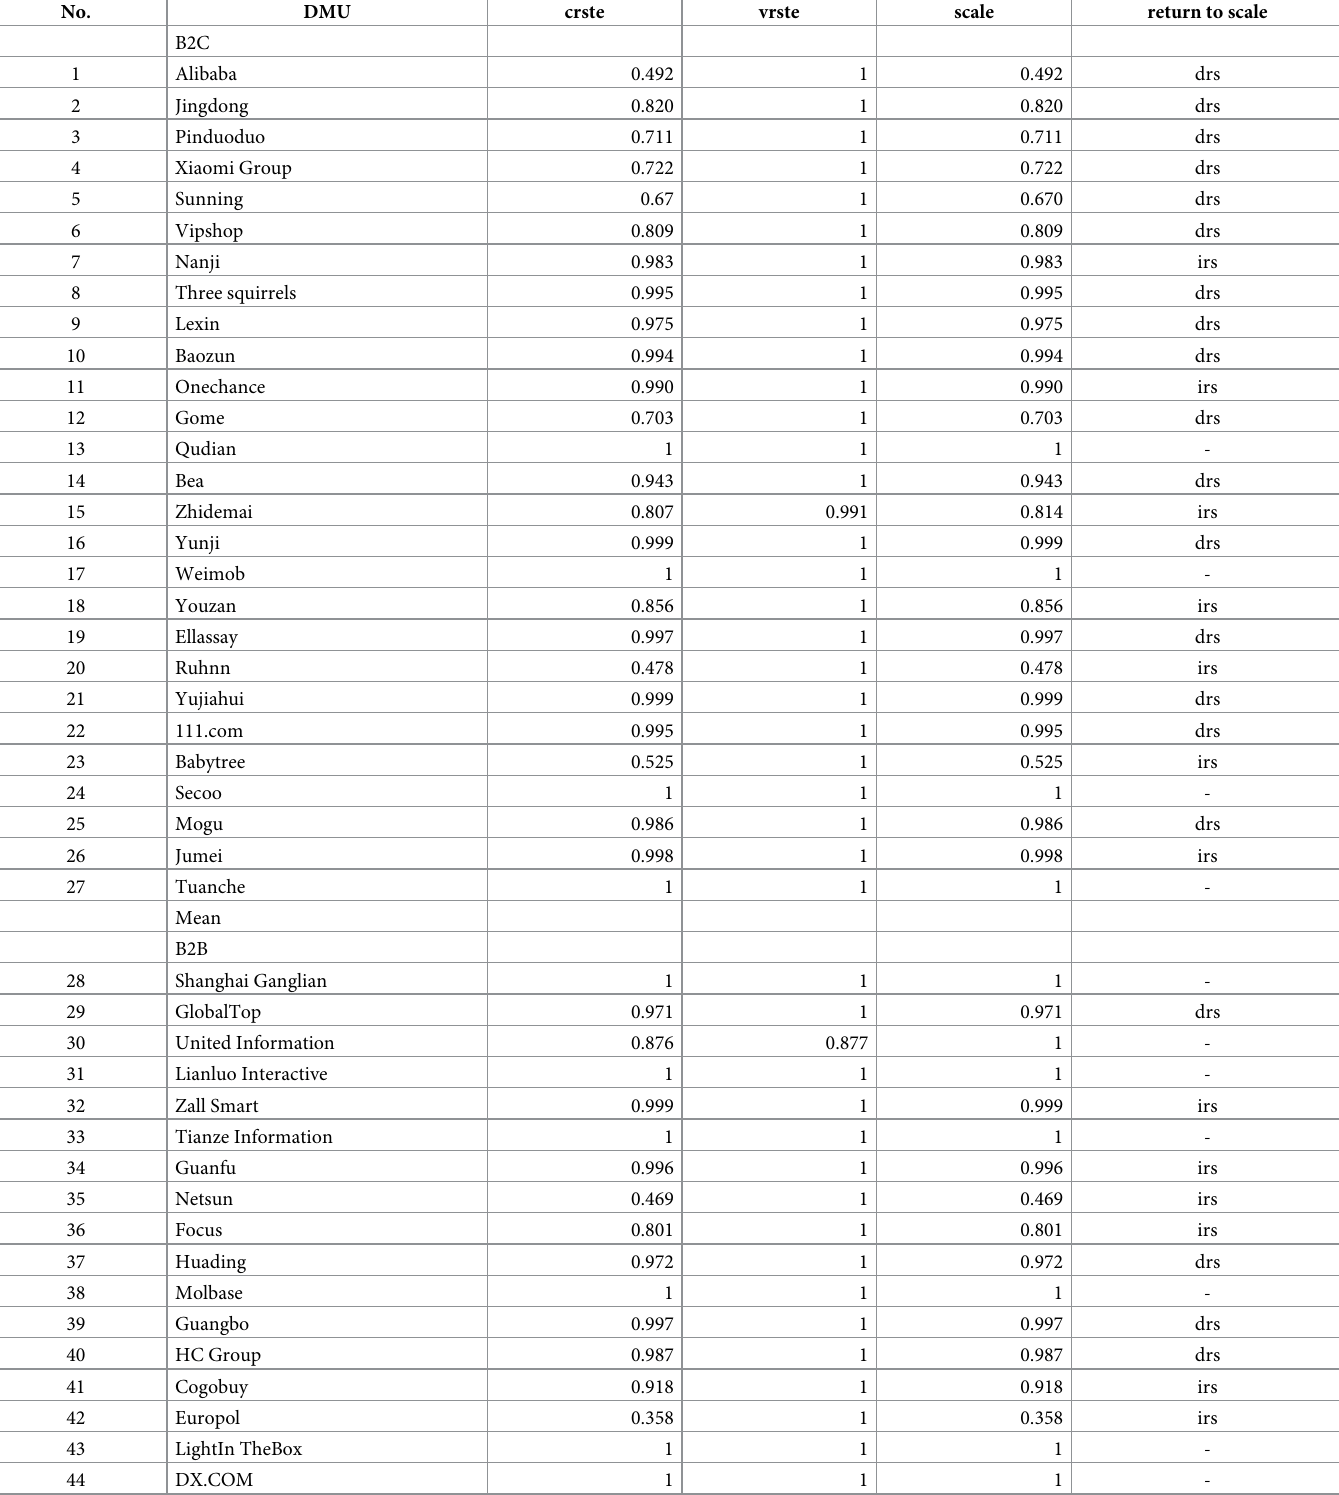
Table 4. Comparison of technical efficiency after adjustment for the input variables of 65 e-commerce firms in 2019.